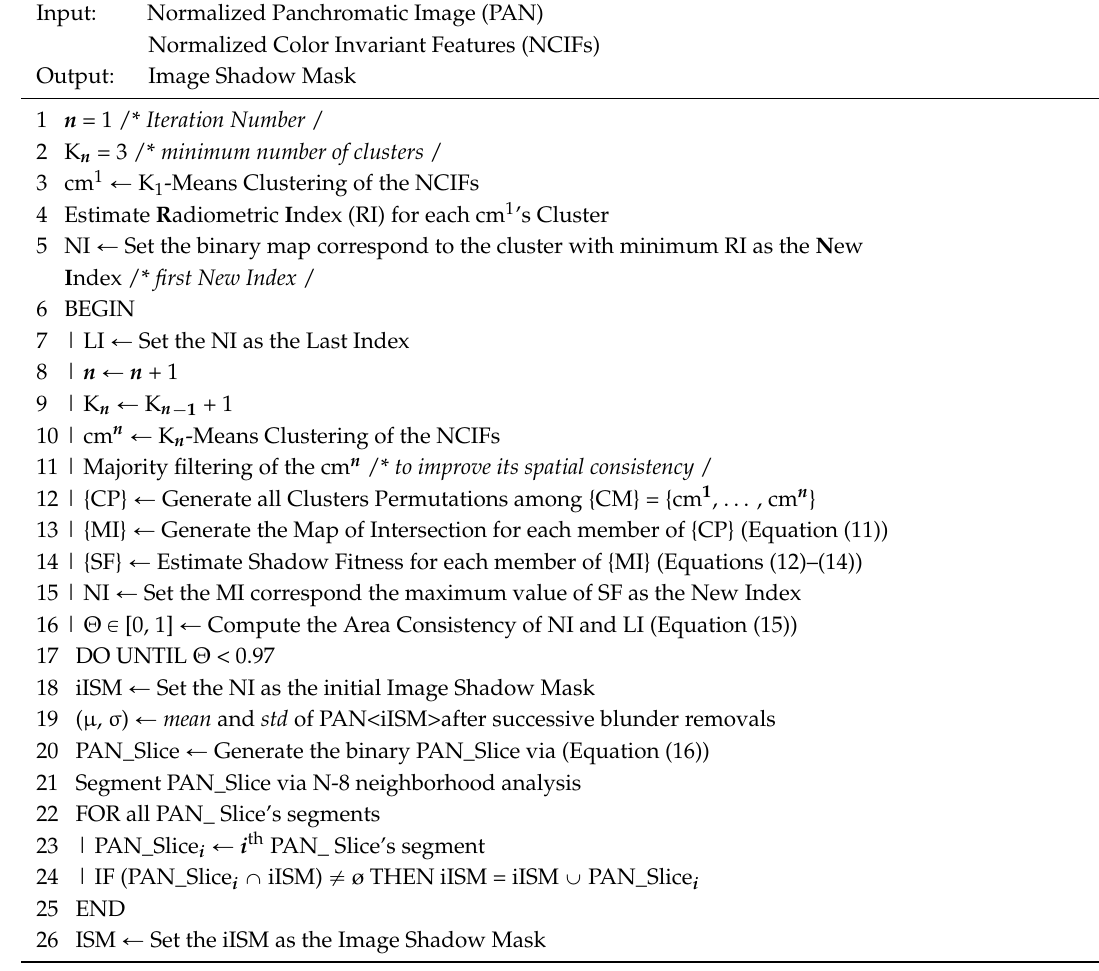
Algorithm 1 Incremental Clustering for Shadows